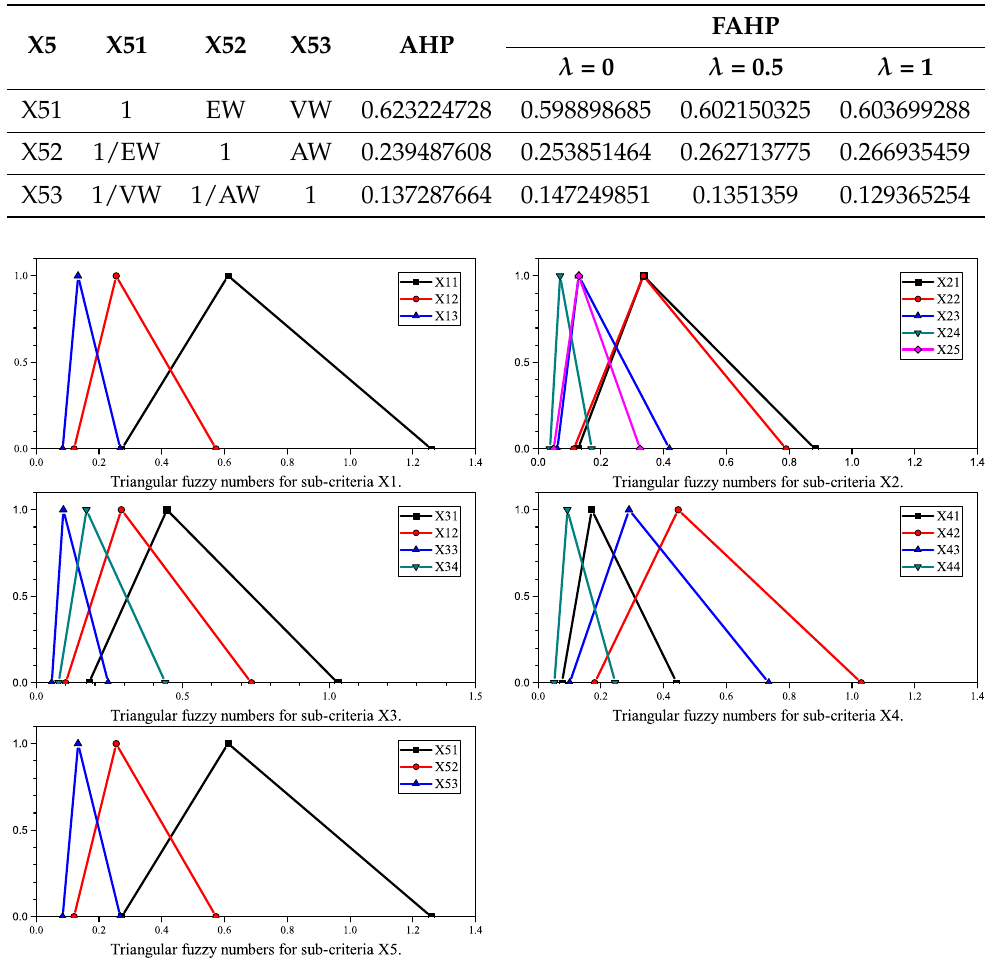
Table 8. Fuzzy comparison matrix for the sub-criteria X5. ( CI = 0.009168629, CR = 0.01580798).